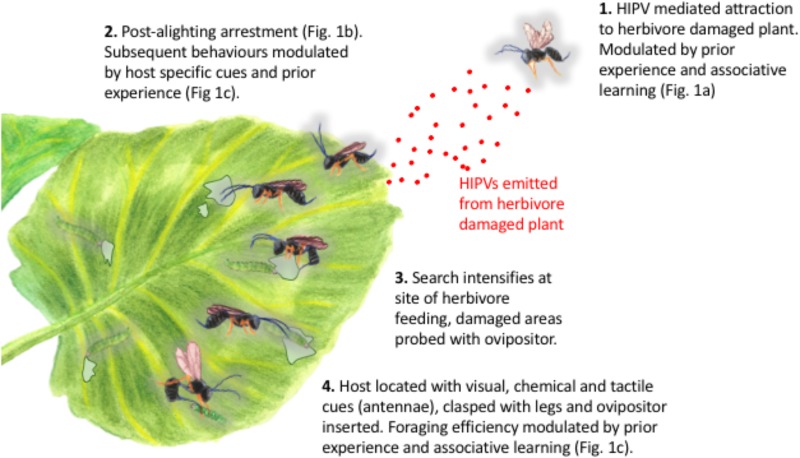
Attraction, orientation and post-alighting behavior of parasitoid wasps in response to host-herbivore infested plants. Post-alighting behavioral sequence based on Diadegma semiclausum Hellén (Hymenoptera: Ichneumonidae) as described by Wang and Keller (2002).